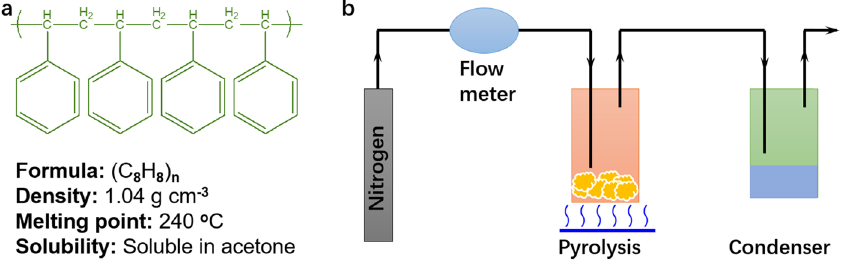
Figure 1: ( a ) Chemical structure of polystyrene. ( b ) Schematic for the setup of polystyrene